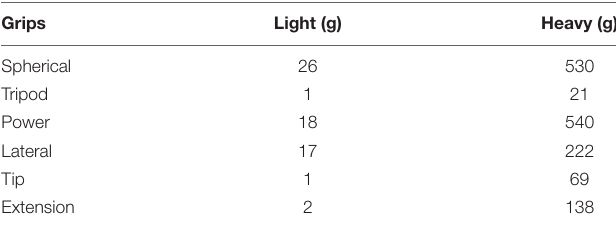
TABLE 2 | Objects’